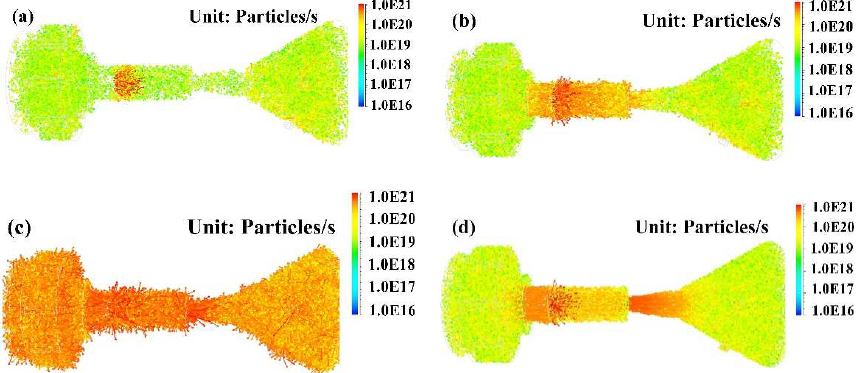
Figure 2. Flux distribution of the gas particles at: ( a ) 100 ns, ( b ) 1 ms, ( c ) 20 ms, and ( d ) 100 ms.